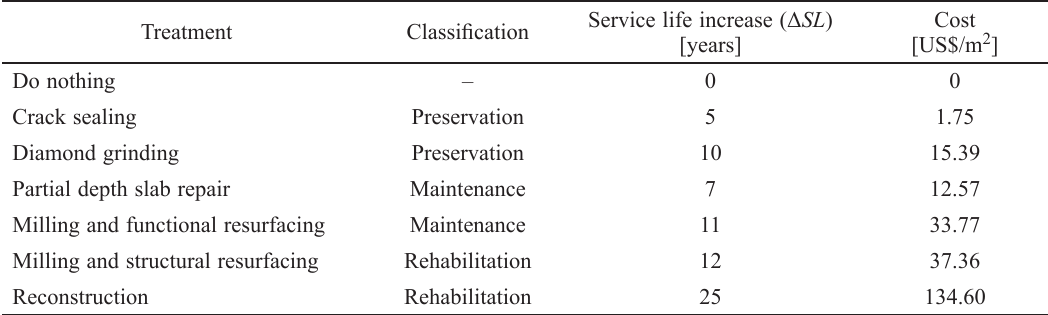
Table 4. Treatment alternatives considered for concrete pavements